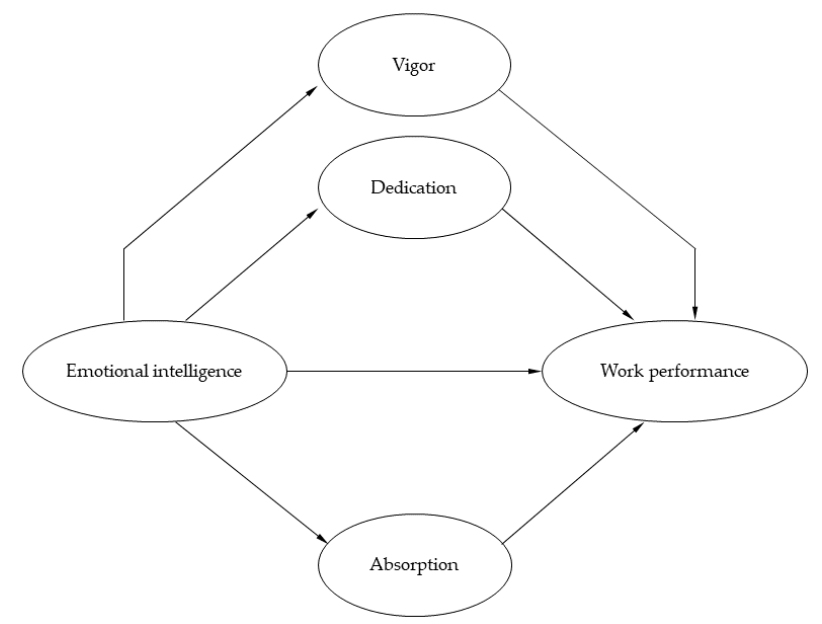
Figure 1. Proposed model of work engagement dimensions mediating the relationship between emotional intelligence and work performance.